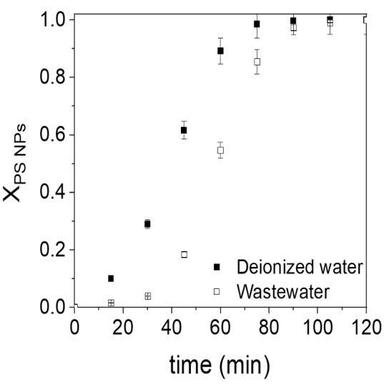
Photo-Fenton oxidation of PS NPs: Effect of the water matrix (D0 = 140 nm; 0 = 100 mg/L; 0 = 1 mg/L; 0 = 1000 mg/L (H2O2 dosed every 30 min, 500 mg/L); pH0 = 3; T = 25 ◦C).